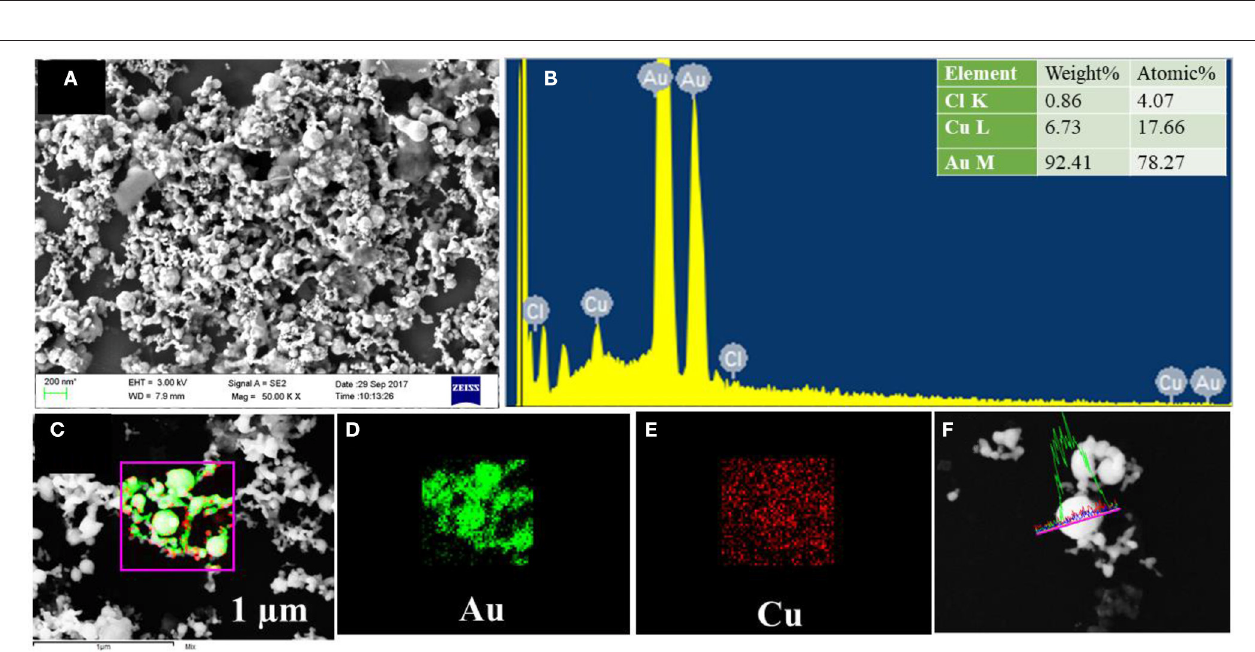
FIGURE 5 | (A) FESEM image of Cu@Au NPs. (B) EDS spectra with inset depicting the wt % of individual elements. (C) EDS mapping image of the Cu@Au NPs. (D) Au EDS map. (E) Cu EDS map. (F) Line profile of the Cu@Au particle clearly demonstrating the presence of both.